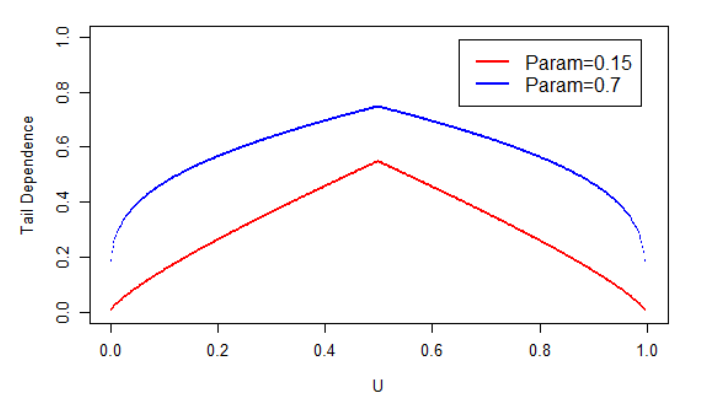
Figure 7. Gaussian copula dependence.